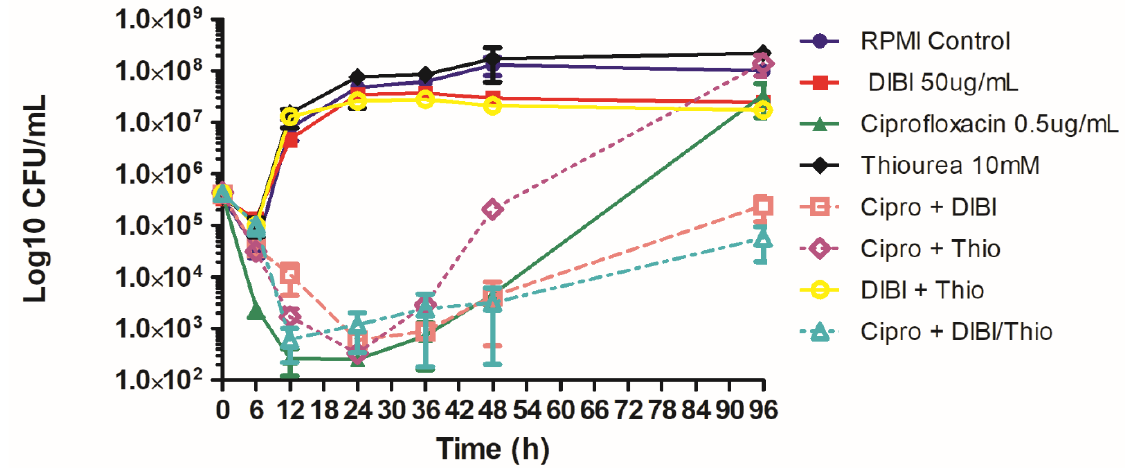
Figure 2. Long term effects of ciprofloxacin, DIBI and thiourea on Staphylococcus aureus killing and recovery growth. ATCC 25923 was grown in MHB and a standardized inoculum was added to 10 mL flask cultures of untreated RPMI control (●), RPMI with added 50 µg/mL DIBI (▪), 0.5 µg/mL CIP ( ▲ ), 10 mM thiourea ( ♦ ), 50 µg/mL DIBI combined with 0.5 µg/mL CIP ( □ ), 10 mM thiourea combined with 0.5 µg/mL CIP (◊) , 50 µg/mL DIBI combined with 10 mM thiourea ( ο ) and 10 mM thiourea combined with 50 µg/mL DIBI and 0.5 µg/mL CIP (Δ). Samples obtained during exposure were plated onto BA and CFU/mL were determined. The data represent means ± SEM for two independent experiments.